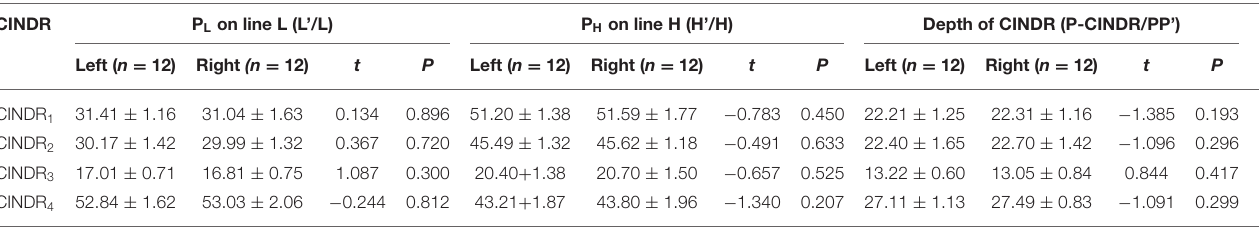
TABLE 1 | Comparison of the location of P L and P H of the CINDRs on lines L and H, respectively, and depth of CINDRs between the left and right sides in suboccipital muscles (%). CINDR P L on line L (L’/L) P H on line H (H’/H) Depth of CINDR (P-CINDR/PP’) Left ( n = 12) Right (n = 12) t P Left ( n = 12) Right ( n = 12) t P Left ( n = 12) Right ( n = 12)